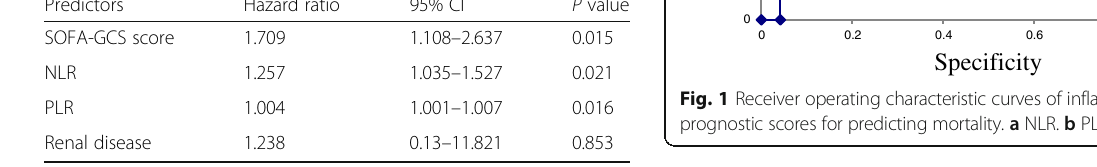
Table 4 Predictors of mortality by multivariate analysis Predictors